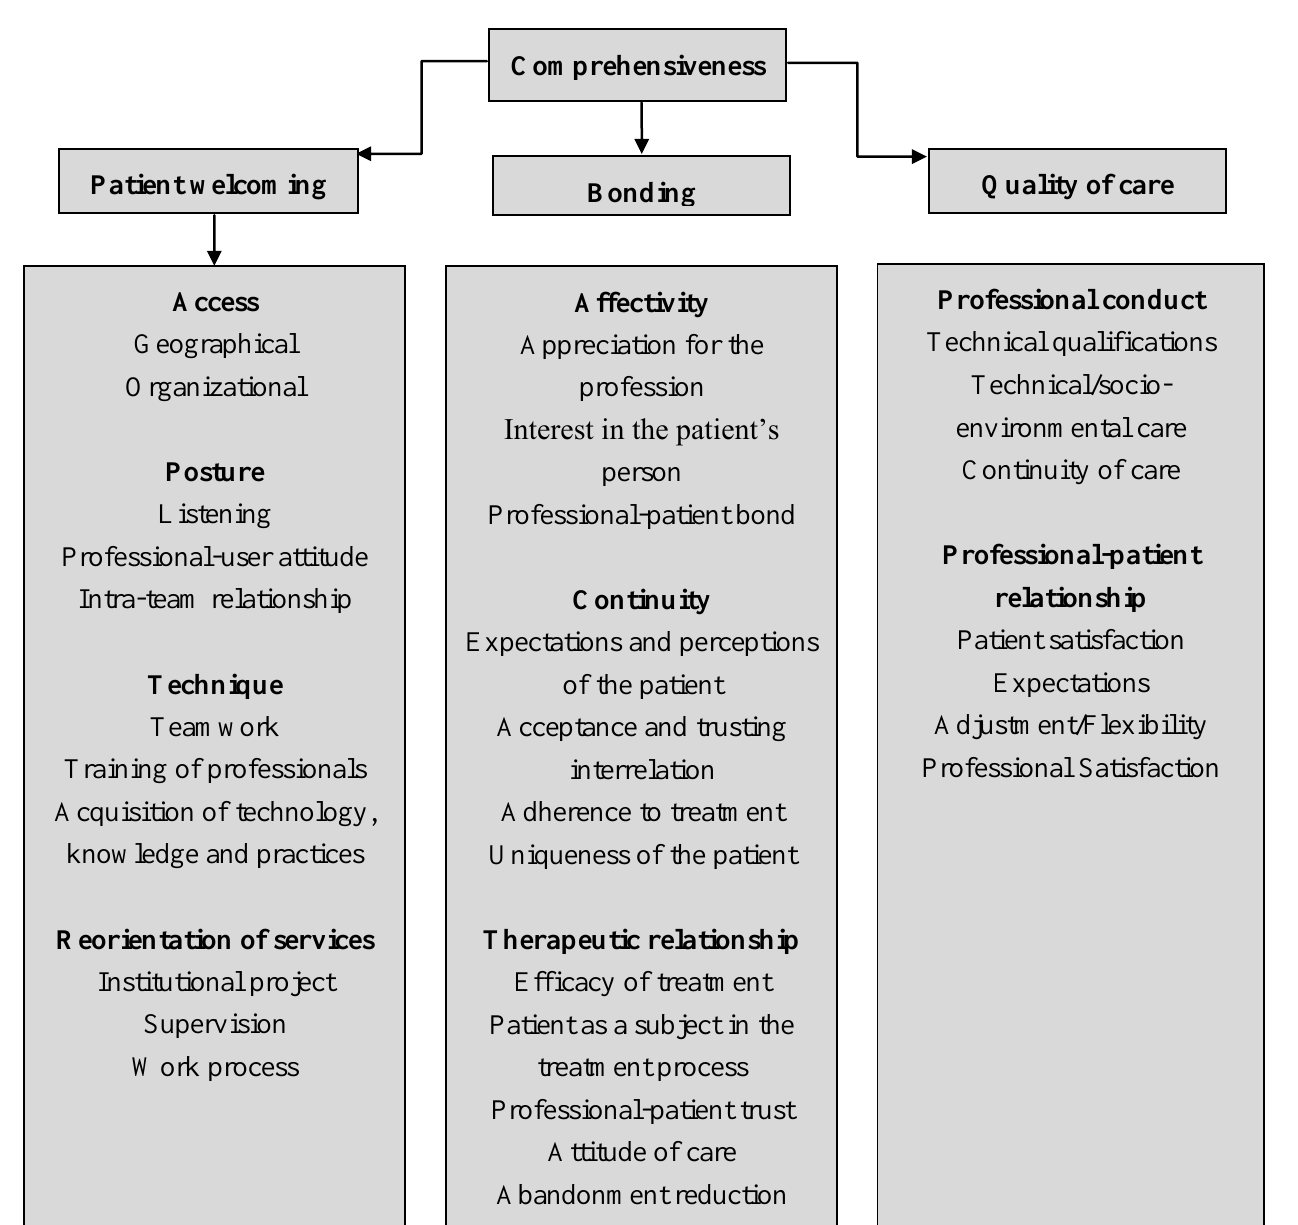
Figure 1. Domains and aspects related to comprehensiveness to be addressed in the assessment of oral health in